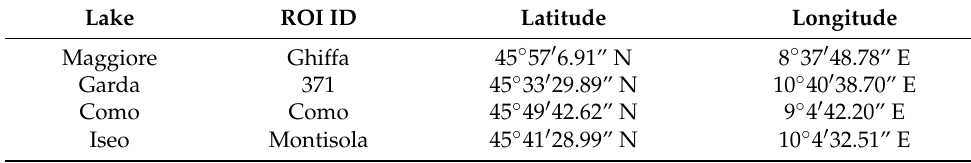
Table 1. The locations of the Regions of Interest (ROI) used to analyze satellite